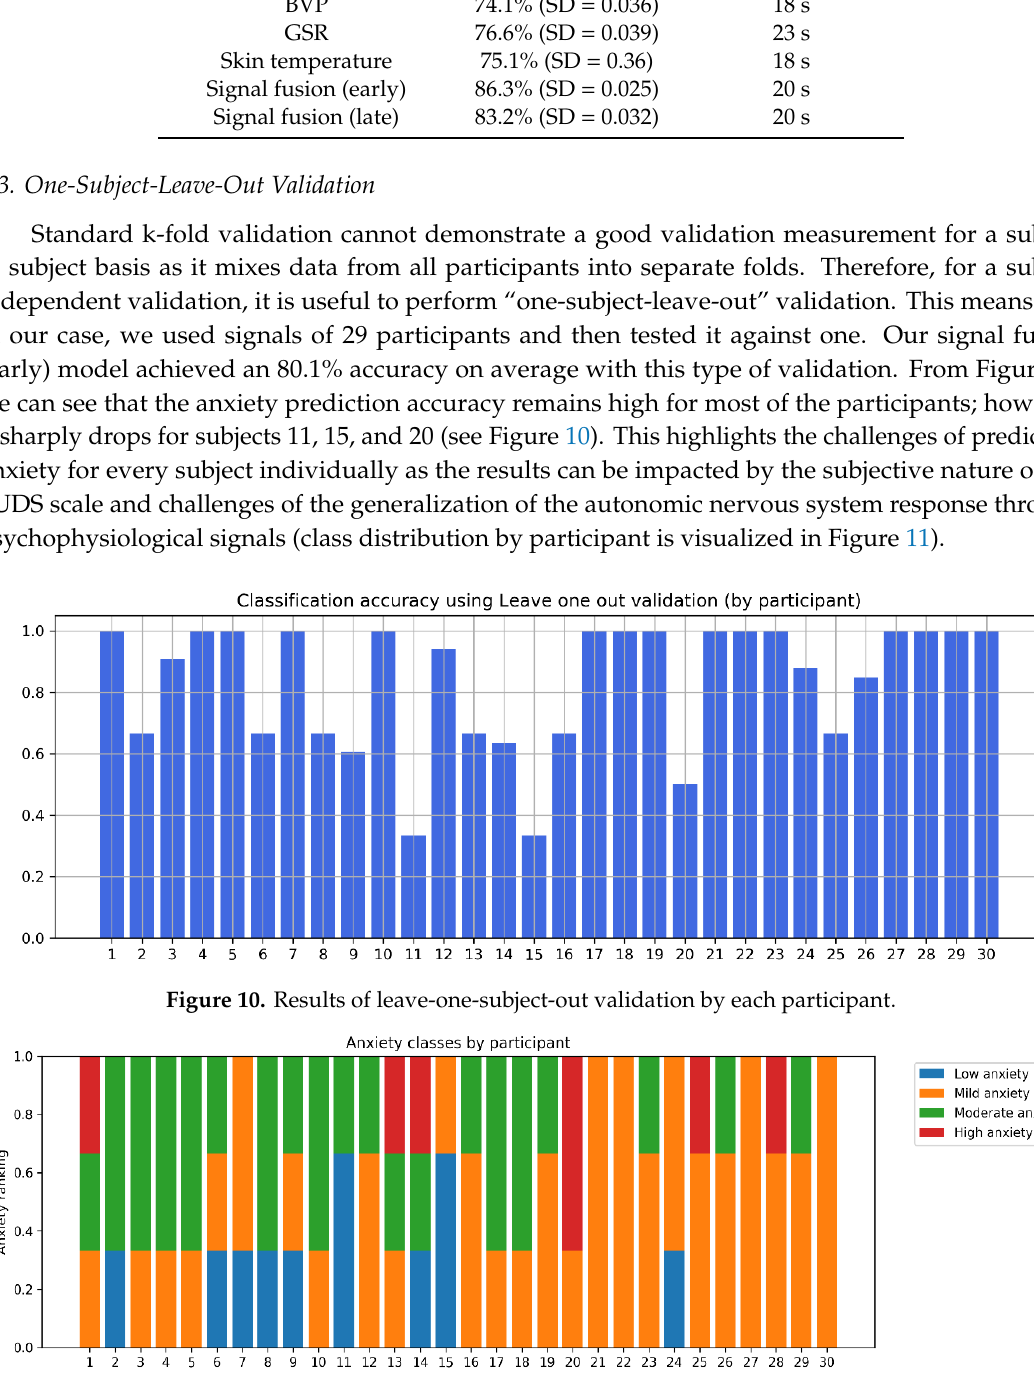
Figure 11. Anxiety levels reported by each participant.